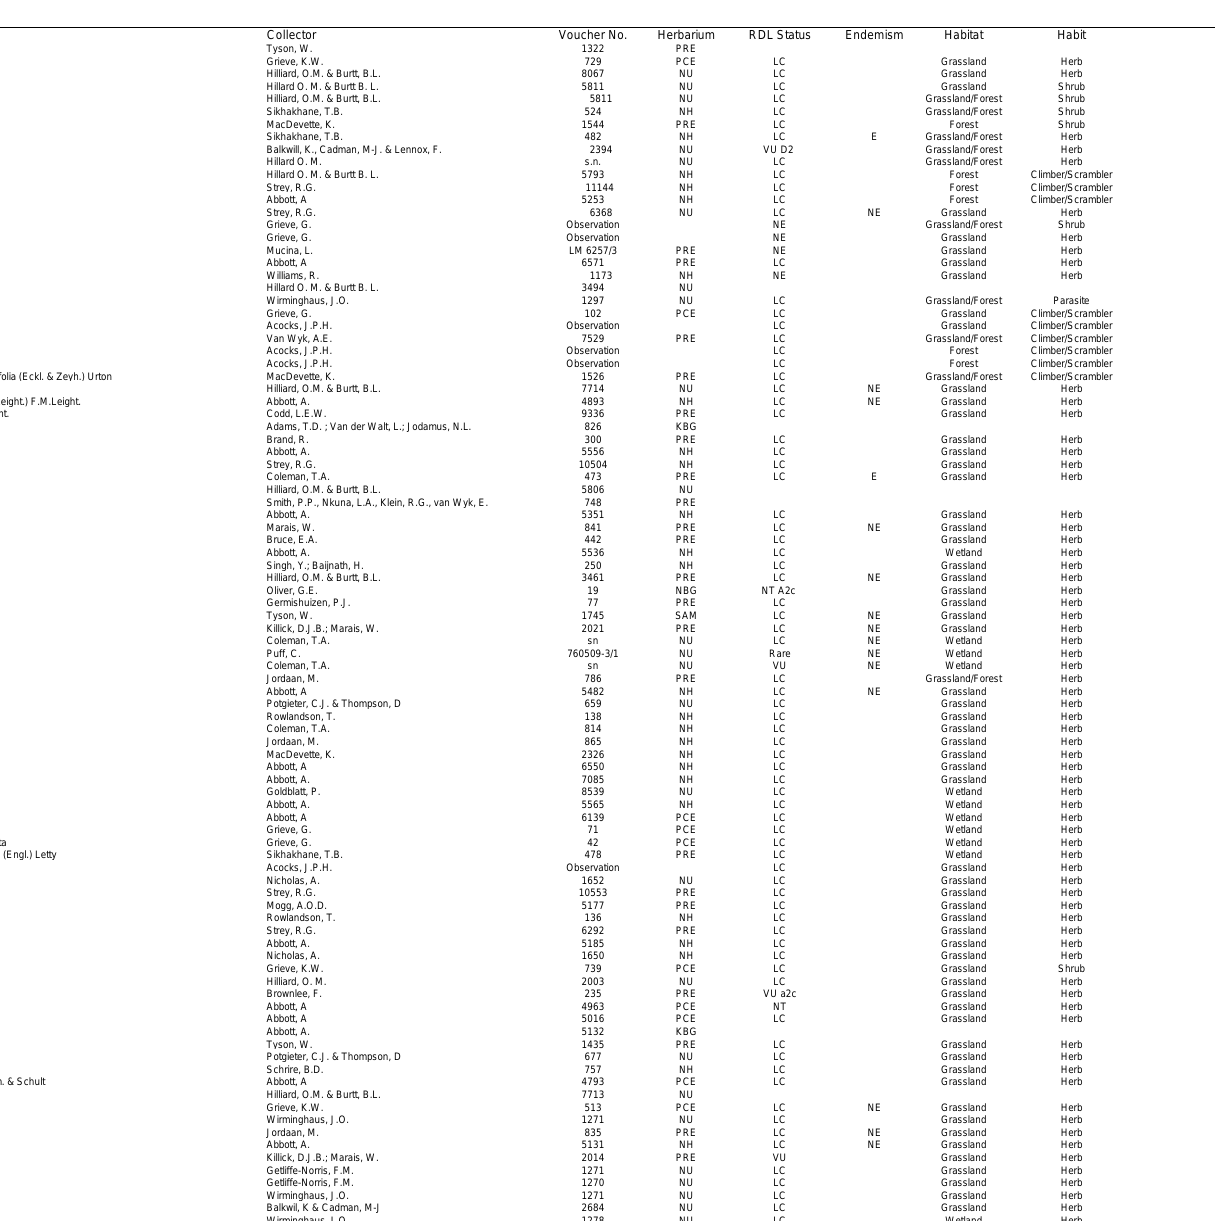
ANGIOSPERMS MONOCOTYLEDONEAE ASPHODELACEAE Bulbine frutescens (L.) Willd. Form asphodelloides (L.) Roem. & Schult Abbott, A Grassland Herb